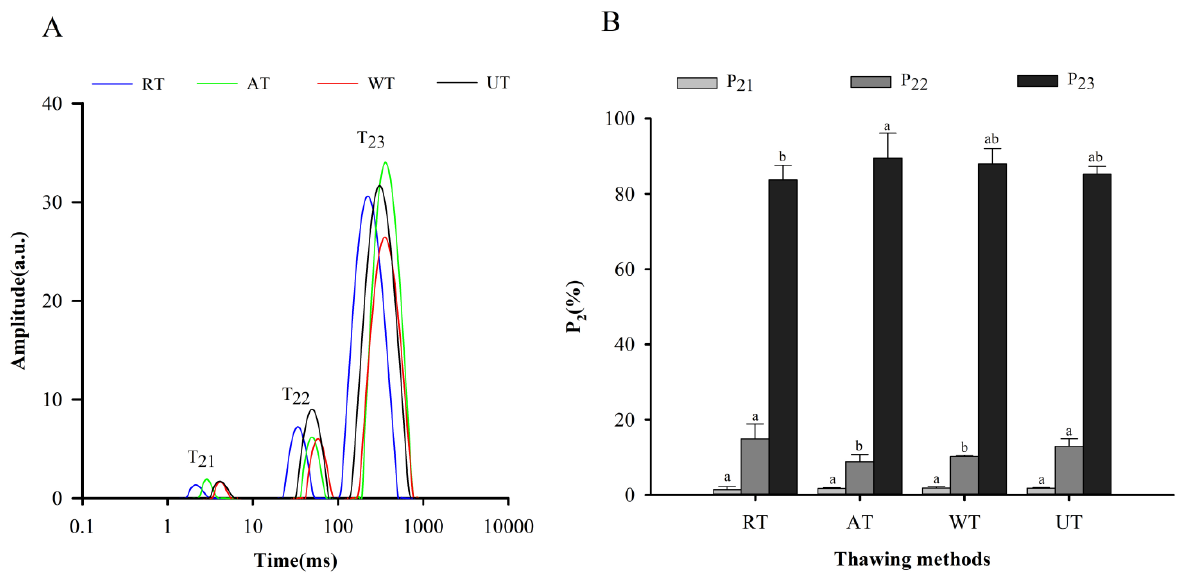
Figure 2. Influence of different thawing methods on the T 2 relaxation time ( A ) and relative water content ( B ) of frozen instant sea cucumber. Values of different groups with different lowercase letters (a – b) are significantly different at p < 0.05.